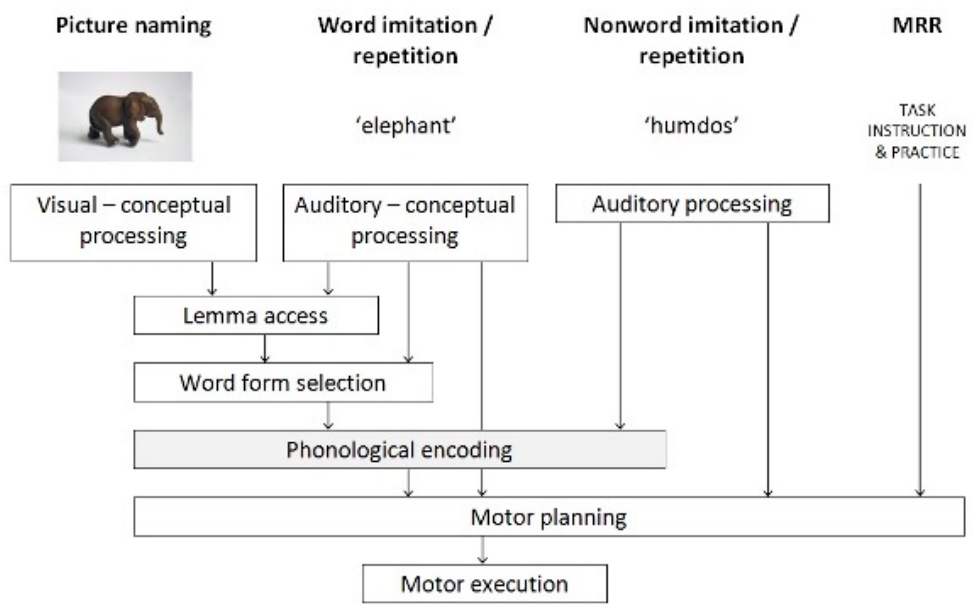
Figure 1. The speech production processes assessed in the four tasks of the Computer Articulation Instrument (Maassen & Terband [11]; Figure 15.2). MRR = maximum repetition rate. Printed with permission.